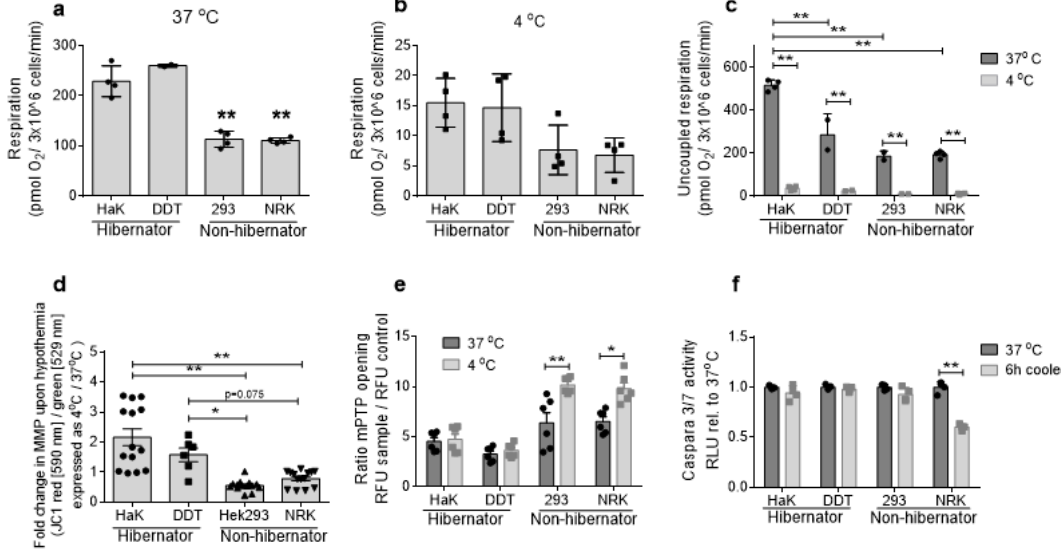
Figure 2. Mitochondrial function during normal temperatures and hypothermia. ( a ) State 3 respiration in digitonin treated cells, energized with malate, glutamate and pyruvate at 37 and ( b ) 4 °C. ( c ) Respiration in Carbonyl cyanide-p-trifluoromethoxyphenylhydrazone (FCCP) treated uncoupled cells at 37 and 4 °C. ( d ) Fold change in mitochondrial membrane potential upon 2h cold incubation. Shown as fold change in hypothermic versus normothermic for JC1 ratio RFU 590/530 nm. ( e ) Mitochondrial permeability transition pore (mPTP) opening in warm and 6h 4 °C treated cells. Presented as random fluorescence units (RFU) probe in absence of cobalt divided by cobalt treated controls. ( f ) Caspase 3/7 activity, presented as fold change in 6h 4 °C treated versus normothermic, random light units (RLU). All data presented as mean ± SD. * = p < 0.05, ** = p < 0.01; ANOVA post hoc Bonferroni.